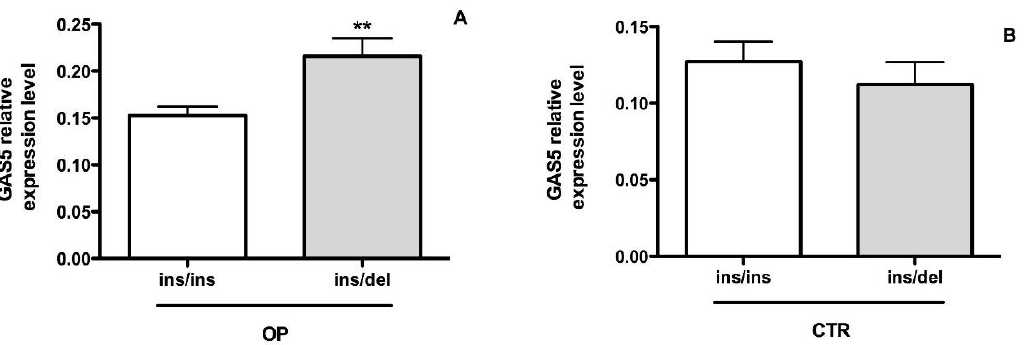
Figure 6. Expression level of GAS5 in OP and CTR individuals with di ff erent rs145204276 genotypes ( A ) GAS5 expression in OP patients with Ins / Del ( n = 17) and Ins / Ins ( n = 39) genotypes (0.22 ± 0.02 vs. 0.15 ± 0.01, ** p < 0.01). ( B ) GAS5 expression CTR subjects with genotype Ins / Del ( n = 7) and Ins / Ins ( n = 21), respectively (0.12 ± 0.05 vs. 0.11 ± 0.03 p = 0.5). Statistical di ff erences between groups were analyzed for significance using unpaired Student’s t -test. Error bars indicate mean ± s.e.m. OP patients with Ins / Del genotype ( n = 17) revealed a higher expression of GAS5 than those with Ins / Ins genotype ( n = 39) (0.22 ± 0.02 vs. 0.15 ± 0.01, ** p < 0.01). Conversely, CTR subjects with Ins /